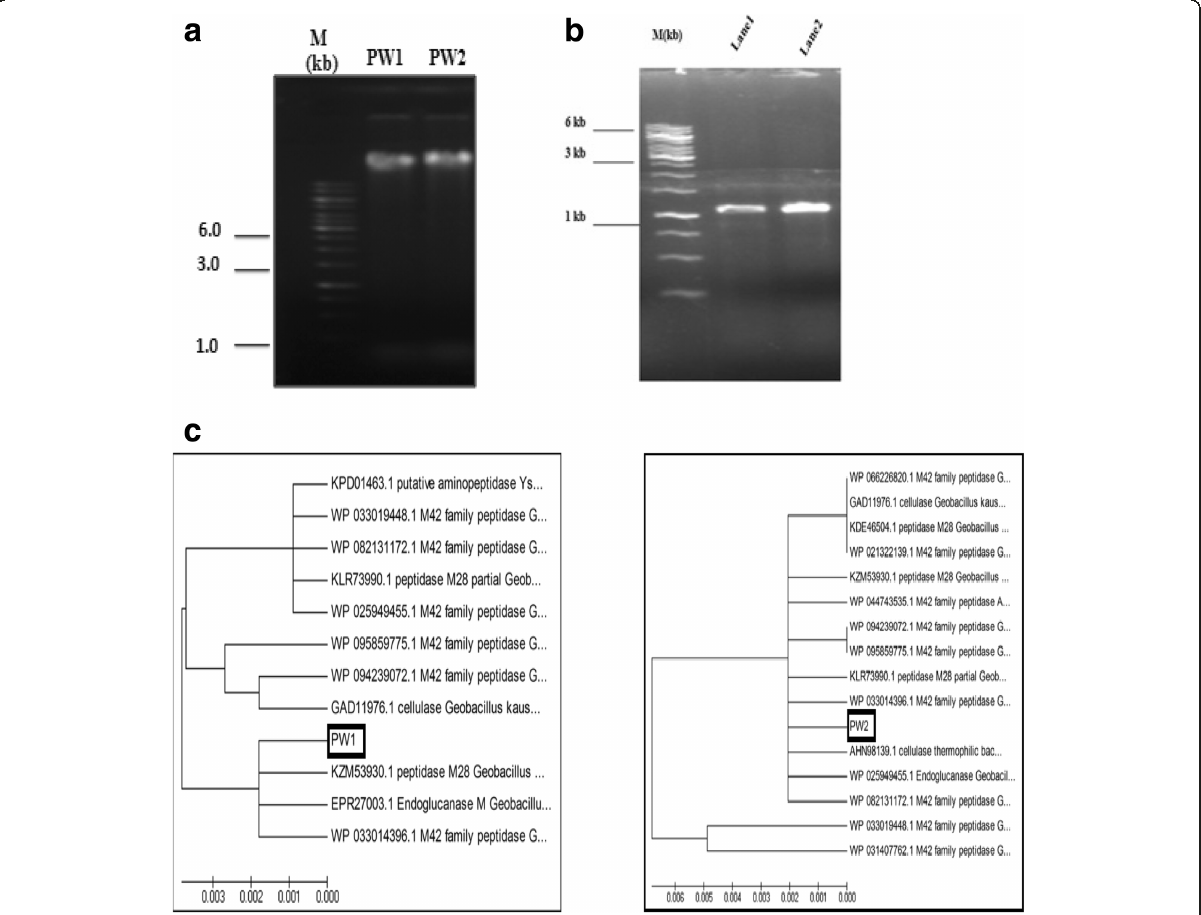
Fig. 2 Isolation of genes encoding cellulase from the thermophiles Bacillus sp. PW1 and Bacillus sp. PW2. a Analysis of genomic DNA of PW1 (lane 1) and PW2 (lane 2) by agarose gel electrophoresis. b PCR amplification of cellulase gene from genomic DNA of PW1 and PW2. Lanes 1 and 2: PCR products showing amplification of cellulase gene of Bacillus sp. PW1 and Bacillus sp. PW2 (~ 1.1 kb), respectively. The size marker (M) bands are indicated (kb). c Dendrogram showing phylogenetic relationship of PW1 and PW2 endoglucanase protein sequences with their representatives showing > 99% homology. The Jaccard ’ s coefficient scale for genetic relatedness is indicated below phylogenetic